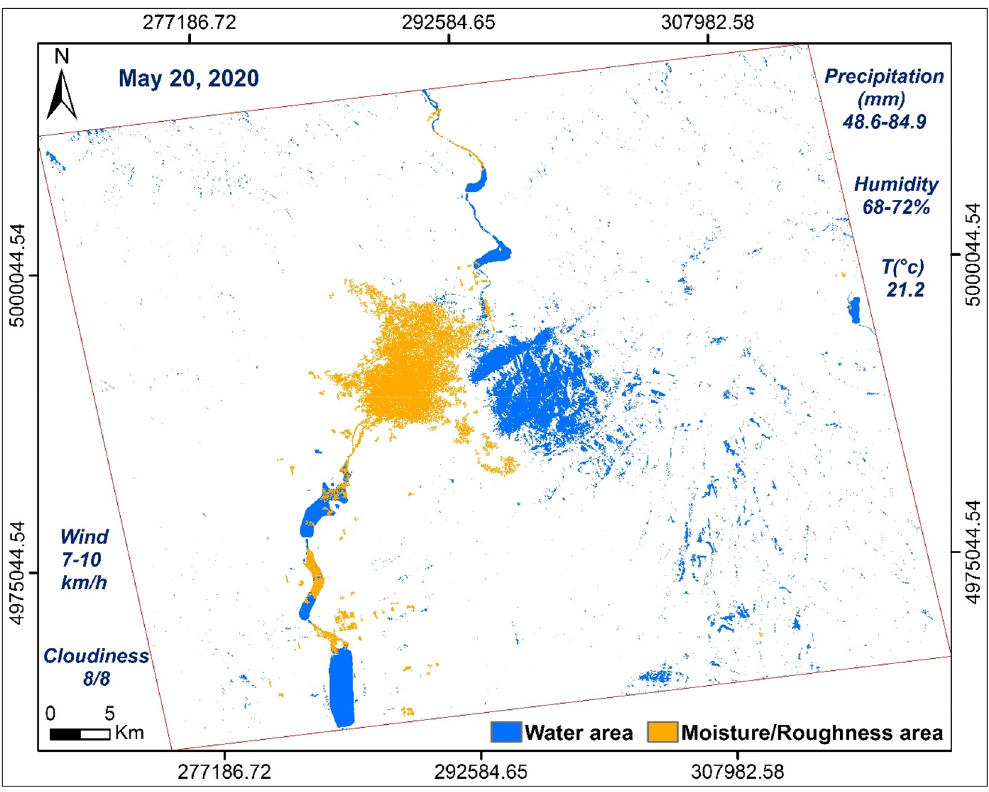
Figure 7. Map produced using ArcGisPro 2.8.1, showing areas of water and moisture/roughness,